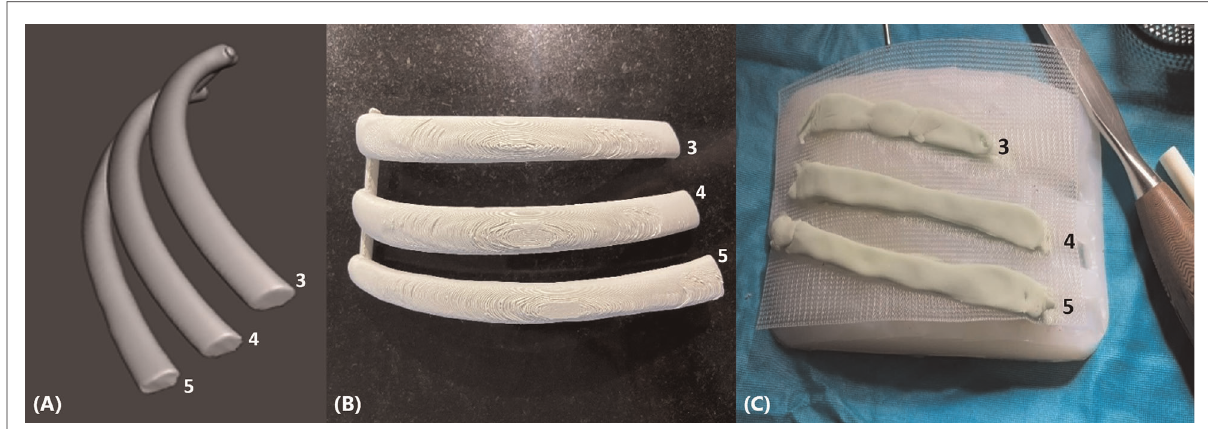
FIGURE 2 ( A ) 3D digital model of the right 3rd, 4th, and 5th rib sections to be resected and reconstructed. ( B ) 3D printed right 3rd, 4th, and 5th rib sections in polylactic acid, used to create the silicone mould. (C) Polypropylene mesh and methyl methacrylate were placed on a silicone mould, which was created from 3D printed rib segments, to create a personalised composite